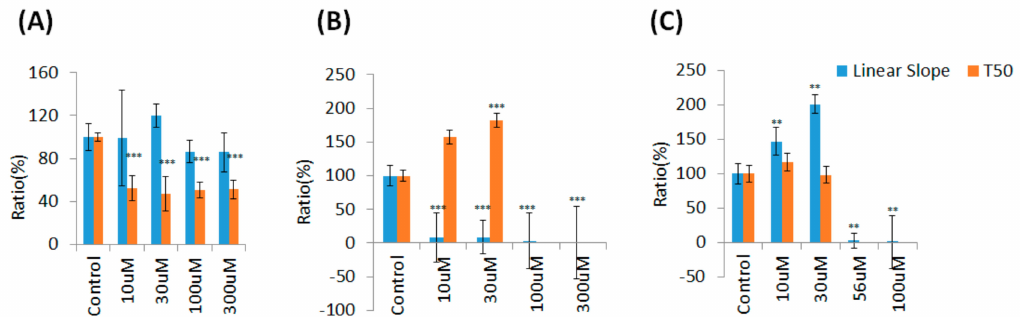
Figure 8. Linear slope and T50 values obtained from the ECIS wound healing assay of U-87 MG cells in response to various concentrations of ( A ) TMZ ( n = 6), ( B ) SAHA ( n = 6), and ( C ) andrographolide ( n = 5). According to the wound recovery data obtained from exposure to 100 µ M and 300 µ M SAHA and 56 µ M and 100 µ M SAHA, the linear slope was too low; therefore, T50 was not calculated and presented. Significance was calculated by comparing each experimental group with their control group. ** p < 0.01; *** p <